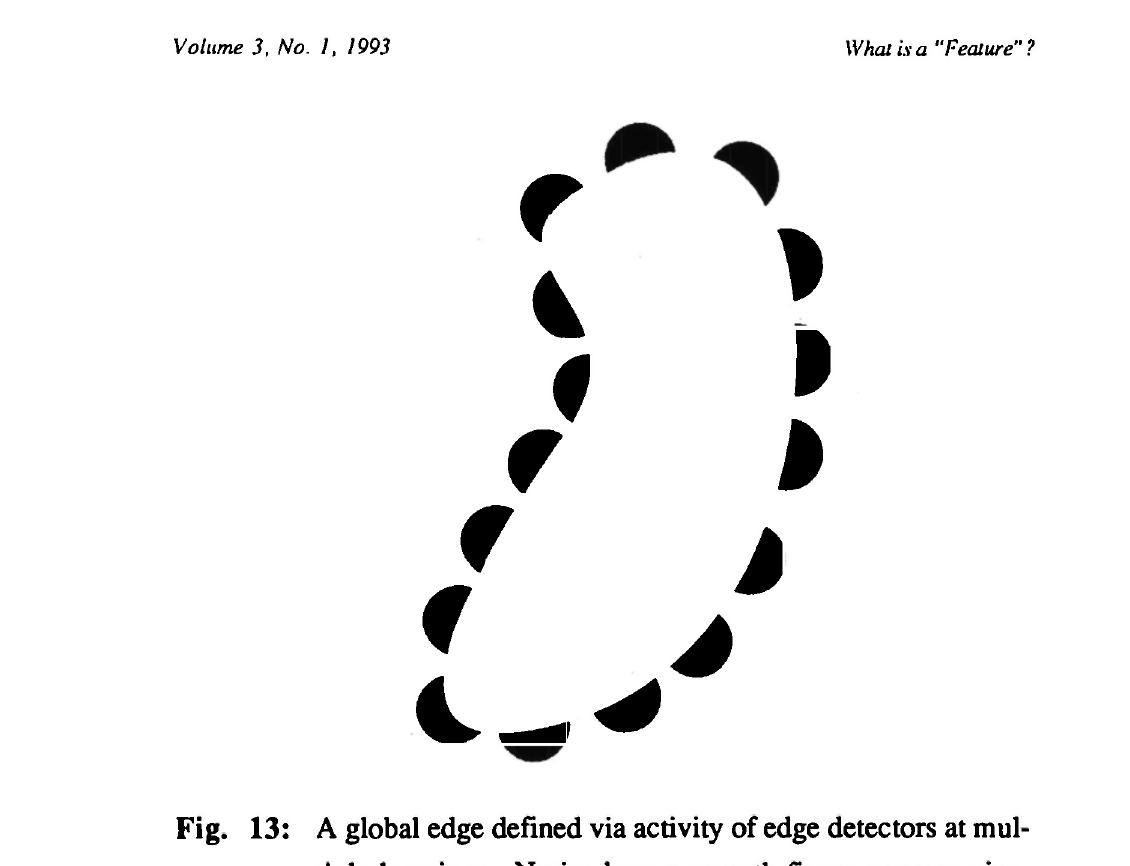
Fig. 13: A global edge defined via activity of edge detectors at mul- tiple locations. Notice how a smooth figure appears visu- ally as a good Gestalt. This type of organization requires a good deal of geometrical